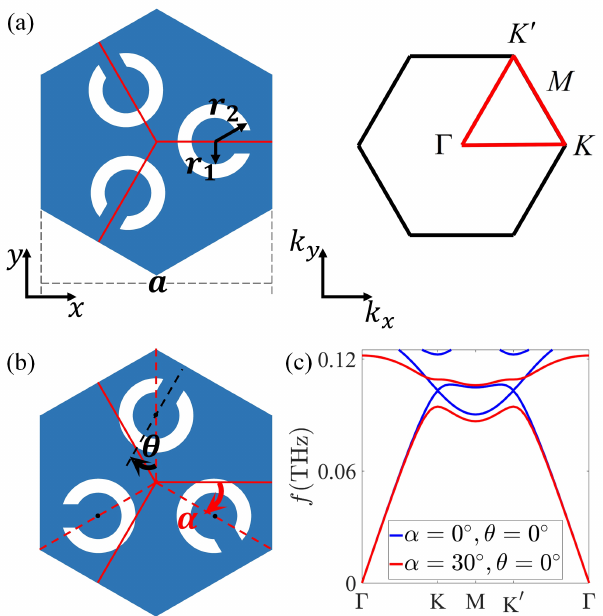
Figure 1. ( a ) The 2D unit cell and first Brillouin zone of C 3 v Kagome SRPI. The geometric parameters are taken as a = 400 µ m, r 1 = 0.1 a , r 2 = 0.16 a . ( b ) C 3 v symmetry-broken unit cell, α and θ are the global and individual rotation of the split rings. ( c ) Photonic bands of the SRPI for α = 0 ◦ , θ = 0 ◦ (blue solid curves) and α = 30 ◦ , θ = 0 ◦ (red solid